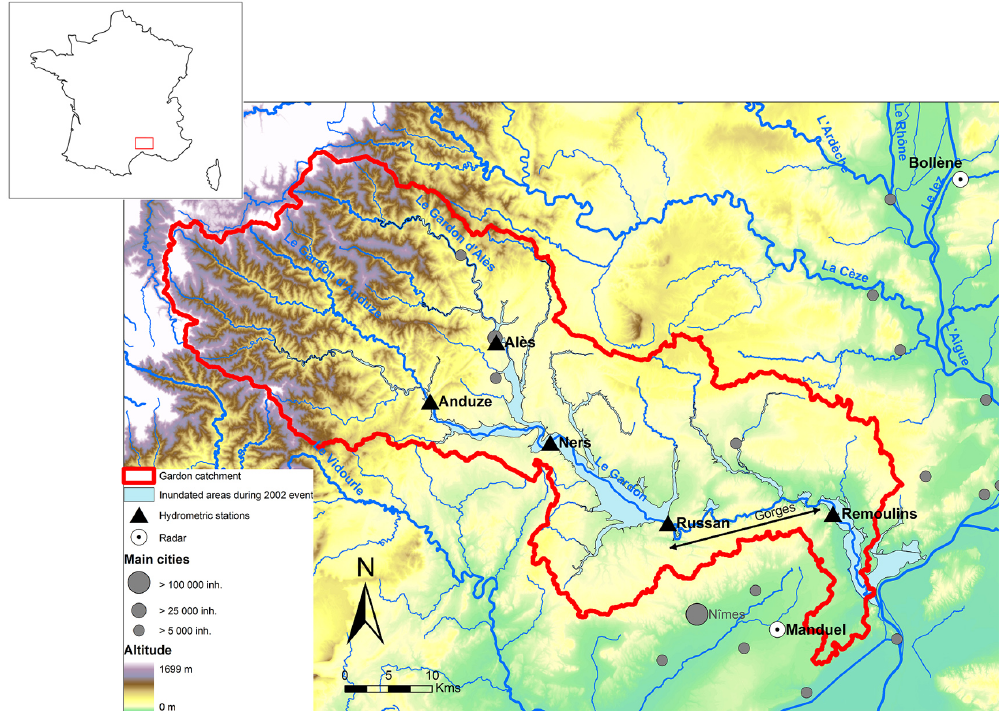
Figure 1. The Gardon